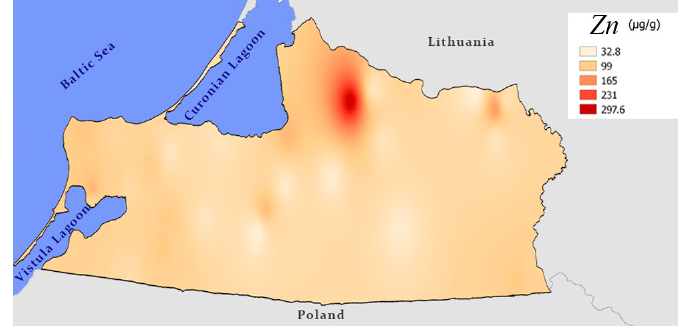
Figure 5. Distribution of zinc in the thalli of H. physodes in the Kaliningrad region, 2010.